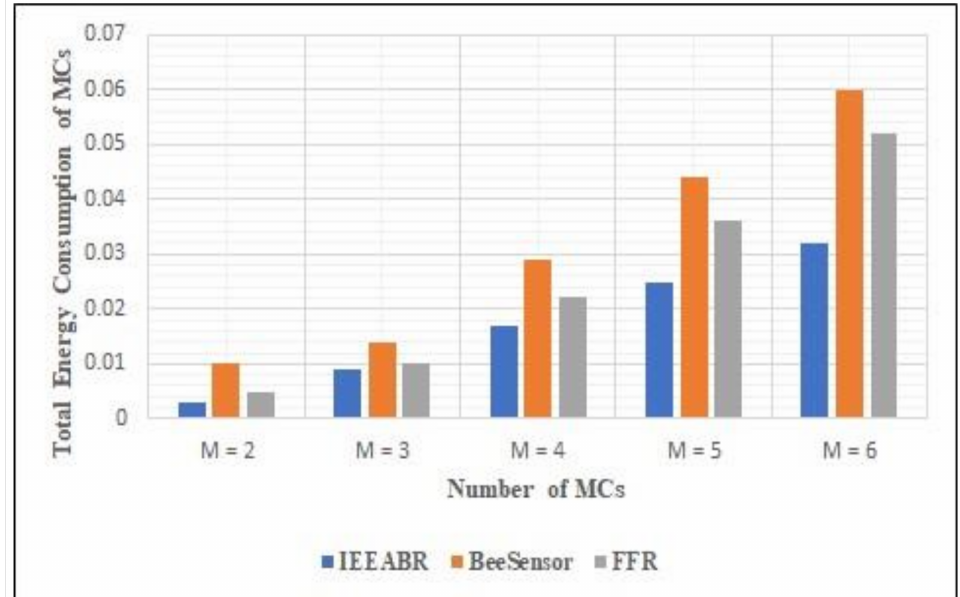
Figure 14. Total energy consumption of MCs.